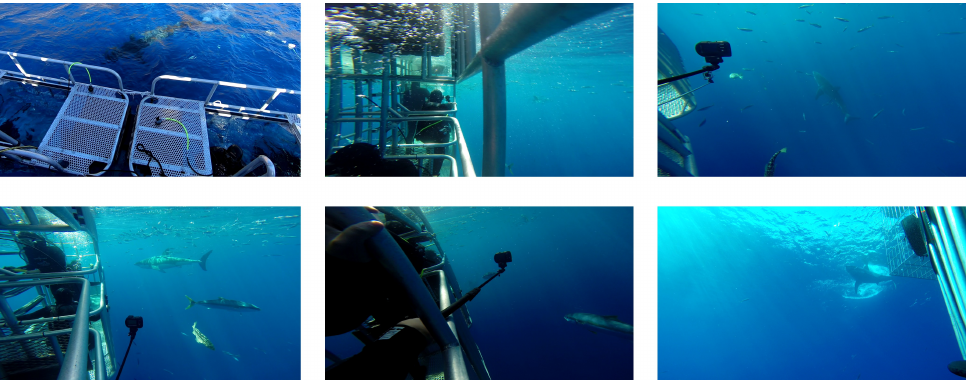
Figure 5. Pictures of collecting visual data from